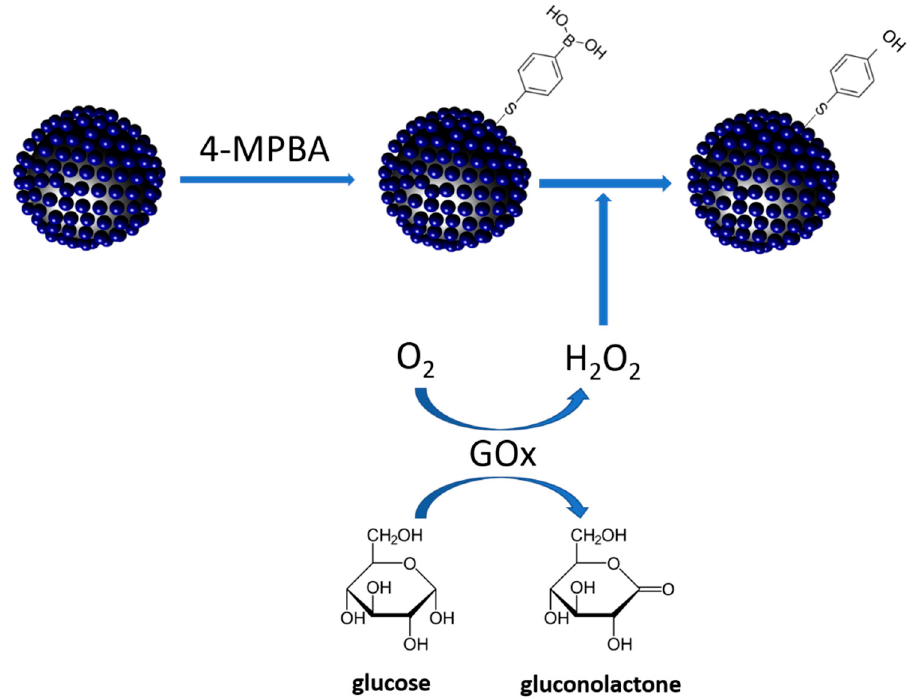
Figure 1. Typical illustration of glucose detection of 4-mercaptophenylboronic acid immobilized- gold-silver core-shell assembled silica nanostructure in the presence of glucose oxidase.